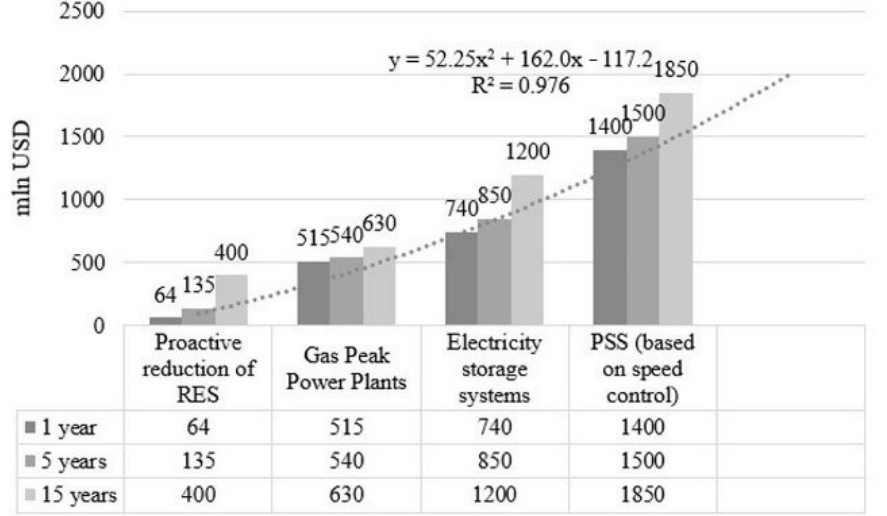
Figure 6. Projected costs for the development of renewable energy in Russia for a sample of